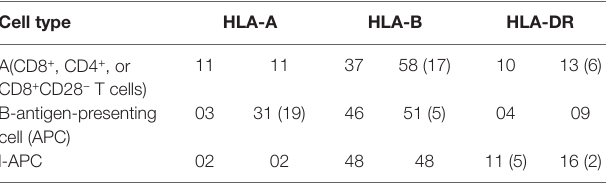
Table 1 | Representative human leukocyte antigen (HLA) typing of donors used for